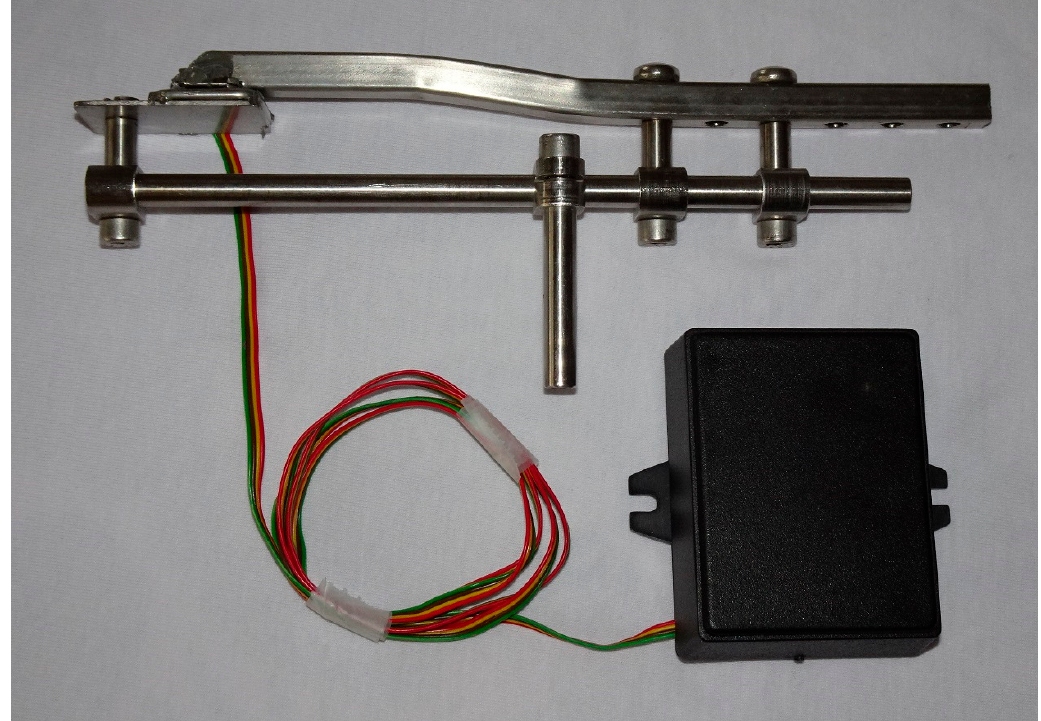
Figure 8. A deformation recording sensor attached to the special arm.